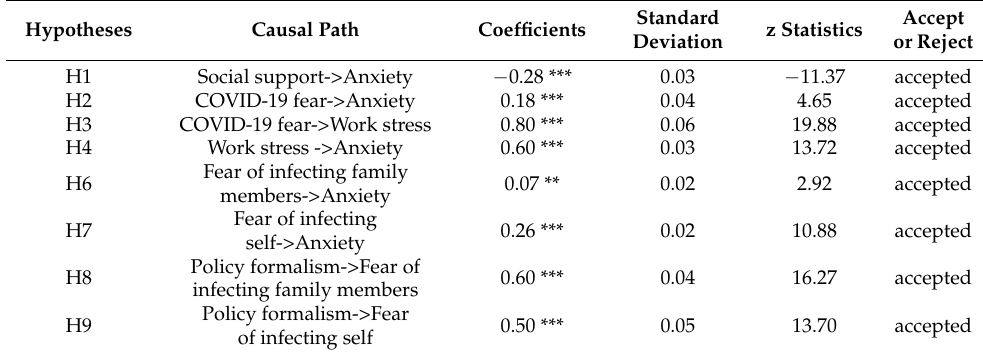
Table 4. Path coefficients (coefficients, STDEV, Z